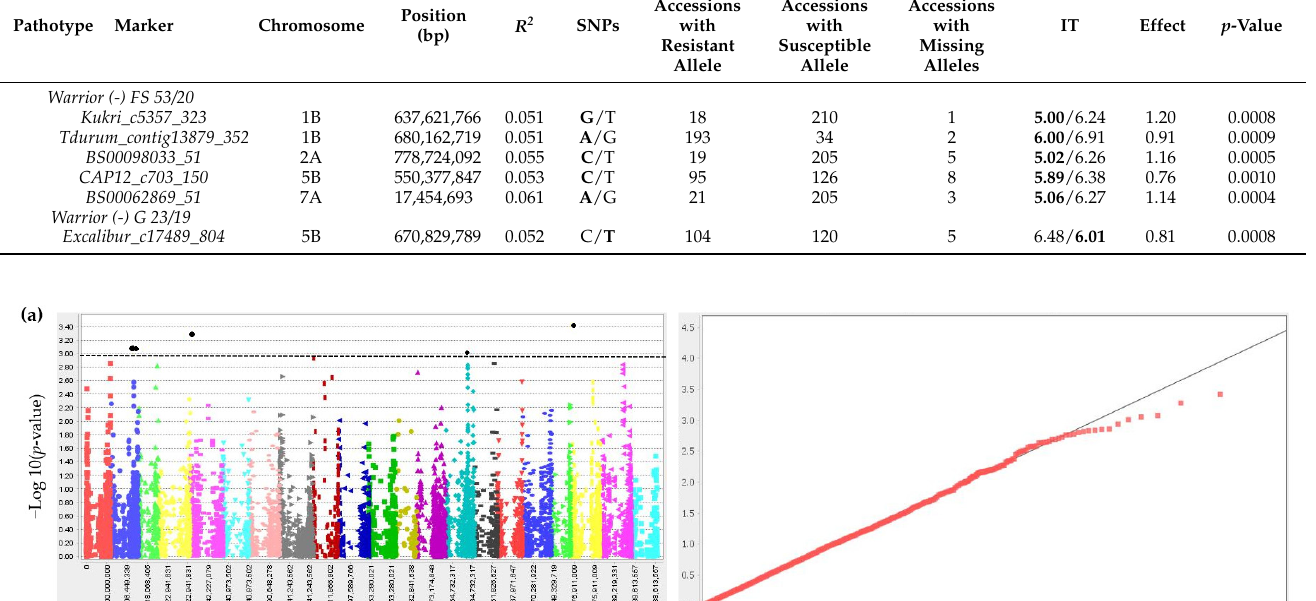
Table 1. SNP markers associated with yellow rust severity (based on IT) for the means of each Pst pathotype. The marker alleles and IT associated with increased resistance are bolded. IT indicates the mean infection type corresponding to the resistant vs. susceptible allele.